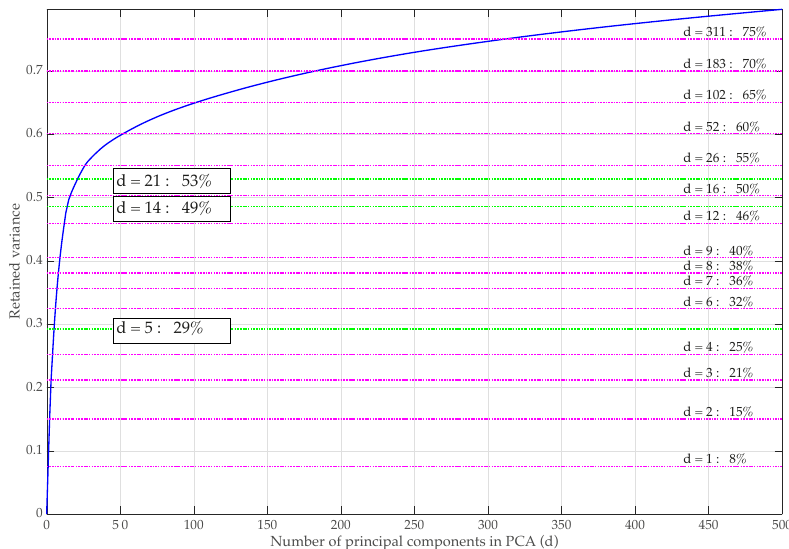
Figure 10. Cumulative explained variance of the PCA model when varying the number of principal components. d = 5, d = 14 and d = 21 components account for 29%,49%, and 53% of the